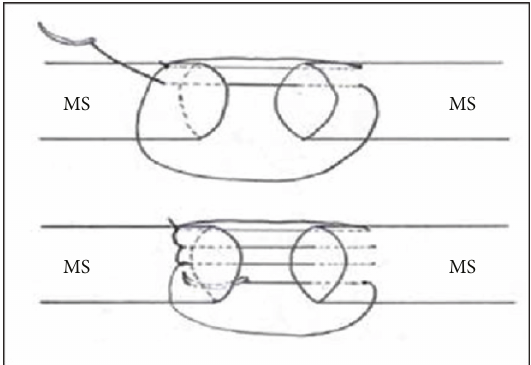
Figure 4: Locking intramuscular sutures secure both the proximal and distal muscle segments (MS).